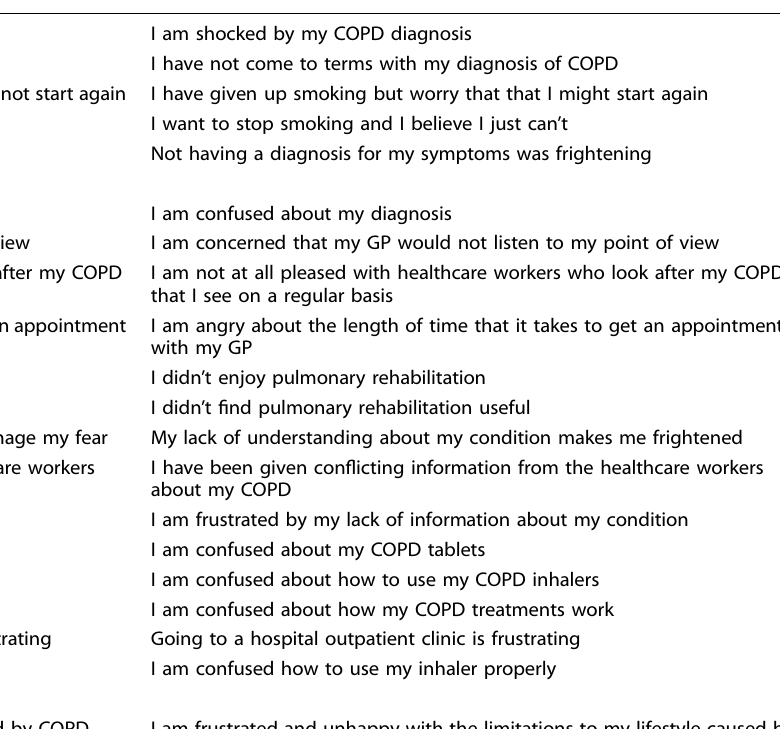
Table 4. Potential PREM items MY HISTORY WITH